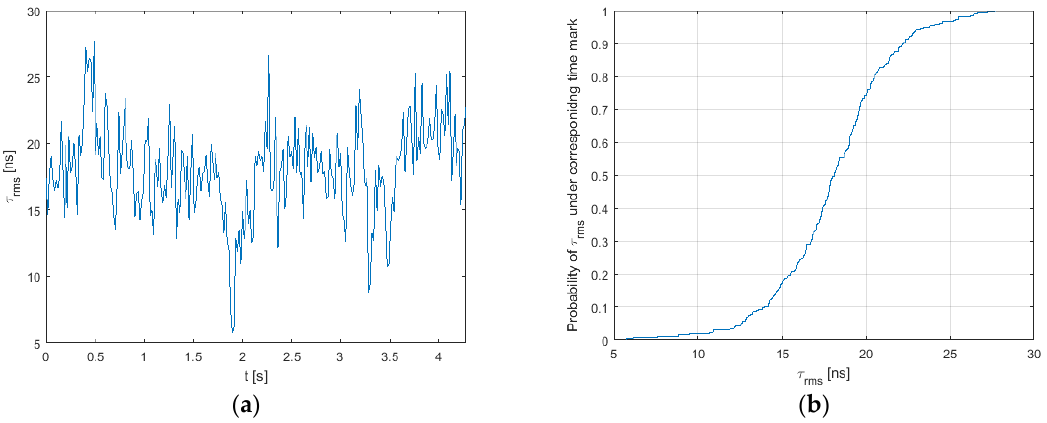
Figure 16. Delay spread in the alley: ( a ) variation along the measurement process; ( b ) CDF of the spread. It is also of interest to obtain the delay-Doppler spectrum (scattering function) of the channel. This is computed as the Fourier transform of the samples corresponding to the different delays. In Figure 17, the delay-Doppler spectra of this campaign, computed both from the original and the aligned responses, are depicted. The asymmetry between positive and negative frequency shifts comes from the fact that, in the initial seconds of the data acquisition, the car is still accelerating to the maximum speed that it can safely reach in the scenario. Therefore, positive frequencies (receiver closing distance to the transmit- ter) reach lesser values. A close-up of to the Doppler spectrum of the main component can be seen in Figure 18.